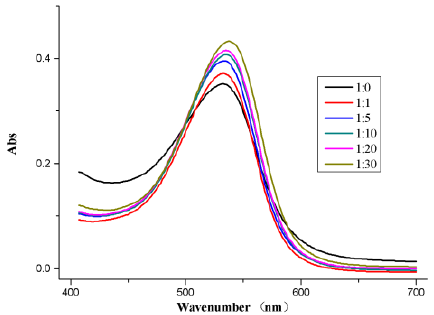
Figure 4. Absorption spectra of ANC (0.5mg/mL) in the presence of FA-g-MD in a pH 3.5 citrate buffer with dimethyl sulfoxide （ DMSO ） . ANC/FA-g-MD mass ratio: 1:0, 1:5, 1:10, 1:20, 1:30.